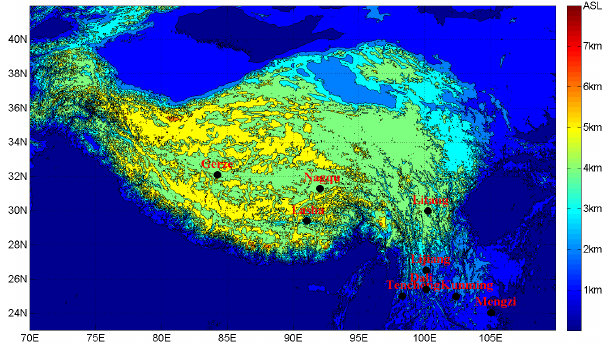
Fig. 1. Distribution of radiosonde sites over the Tibetan Plateau (ASL-elevation above sea level).